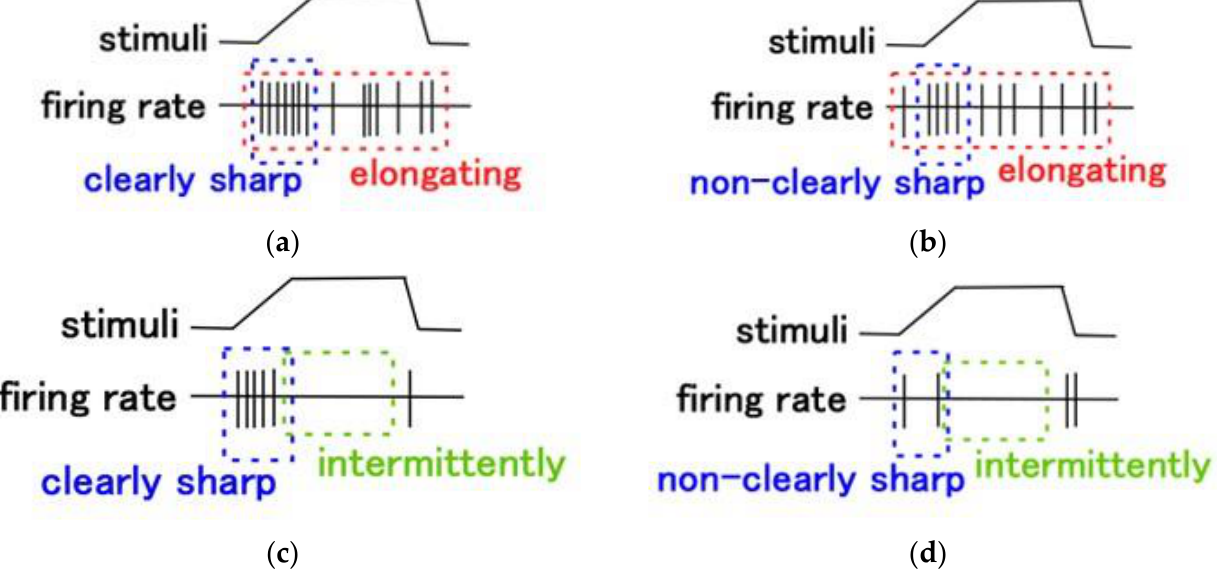
Figure A3. FA and SA of the vital mechanoreceptors by biomedical analysis: ( a ) SA I; ( b ) SA II ( c ) FA I; ( d ) FA II.